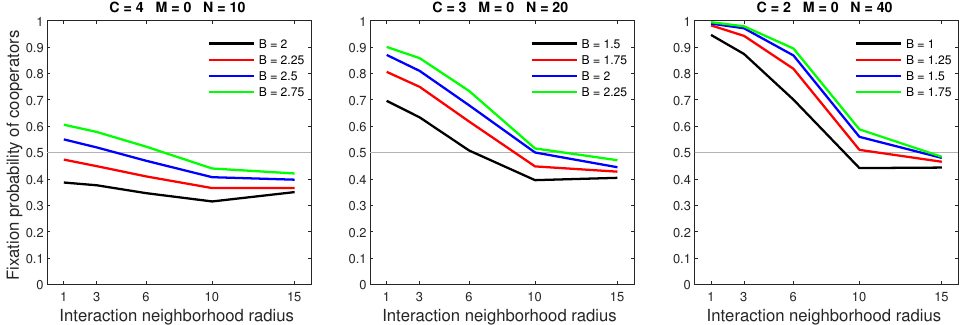
Figure 2. Cooperation is promoted by increasing the benefits of cooperation while keeping the cost fixed. The effects of increased benefits are greatest in sparse populations with small interaction